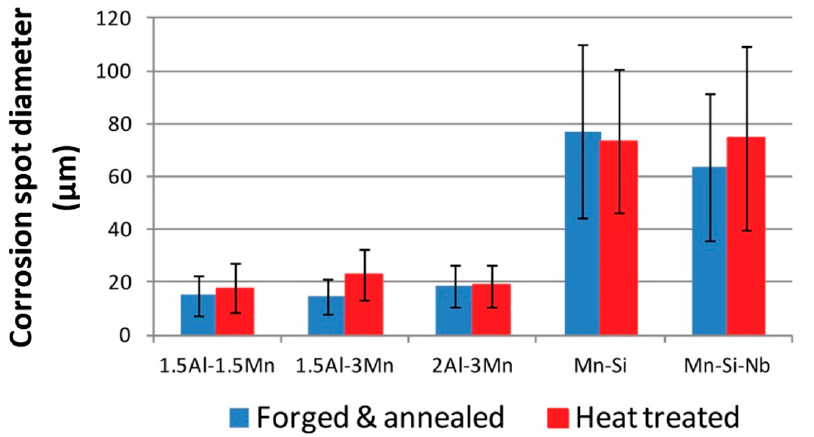
Figure 13. Corrosion spot diameters after 20 min immersion in demineralized water.